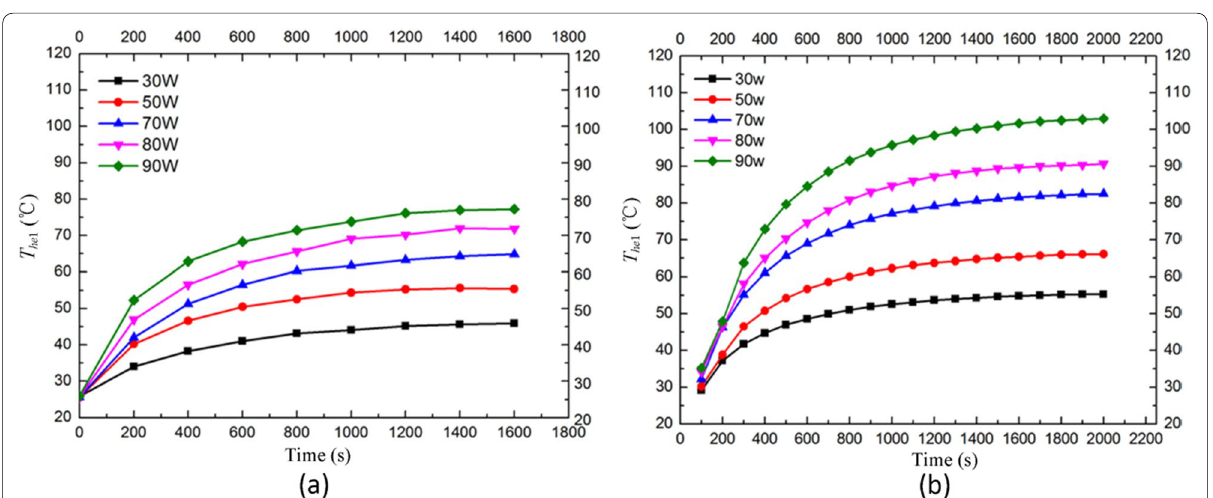
Figure 7 Temperature at the center of the heat sink ( T he 1 ) with time duration in a the micro-channel radiator and b an aluminium